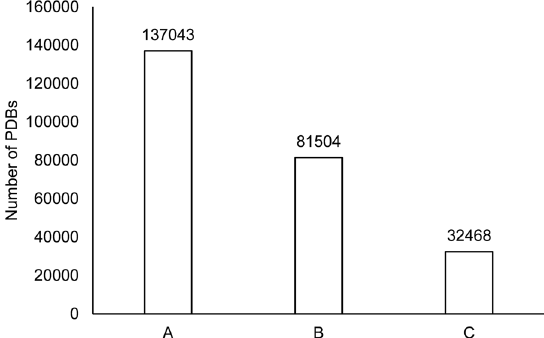
Figure 1. Protein-protein complexes covered in the creation of PPInS. A: Total PDBs, B: PDBs reported in SCOPe 2.06, C: PDBs covered in